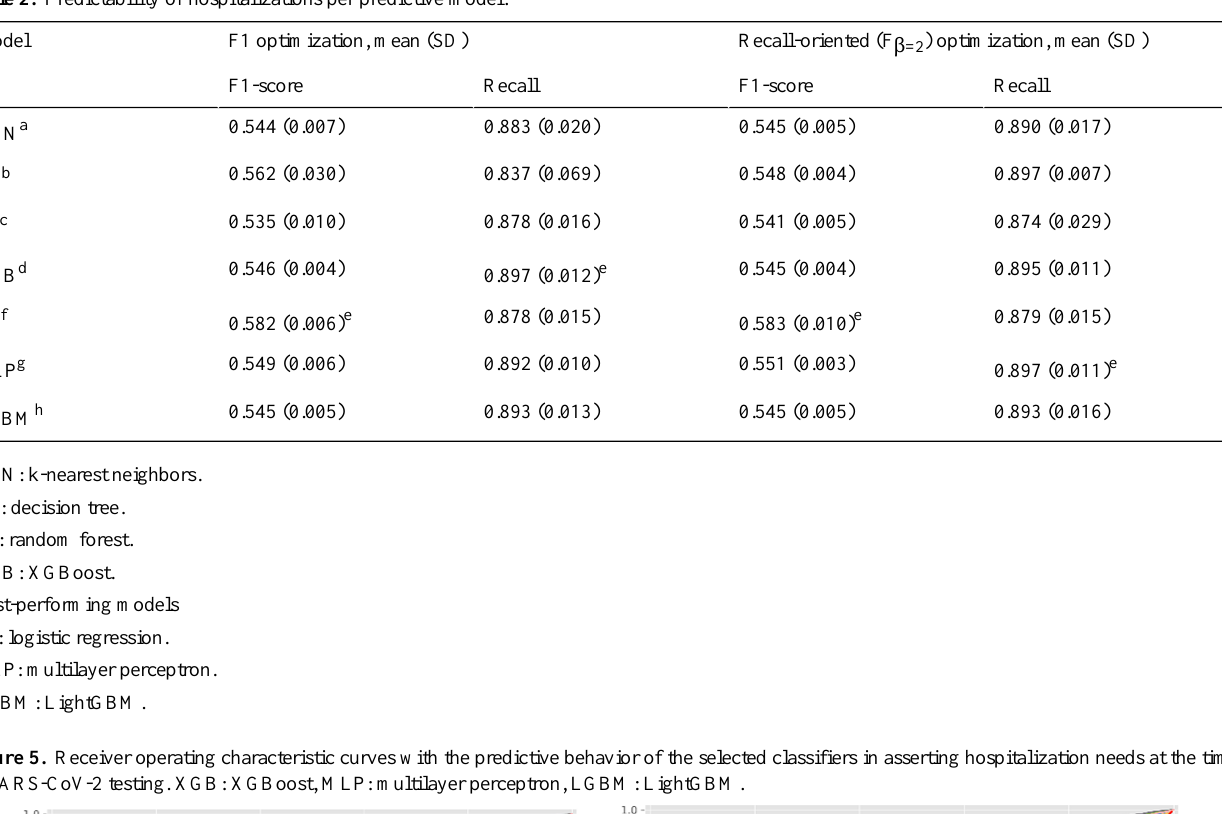
Table 2. Predictability of hospitalizations per predictive model.